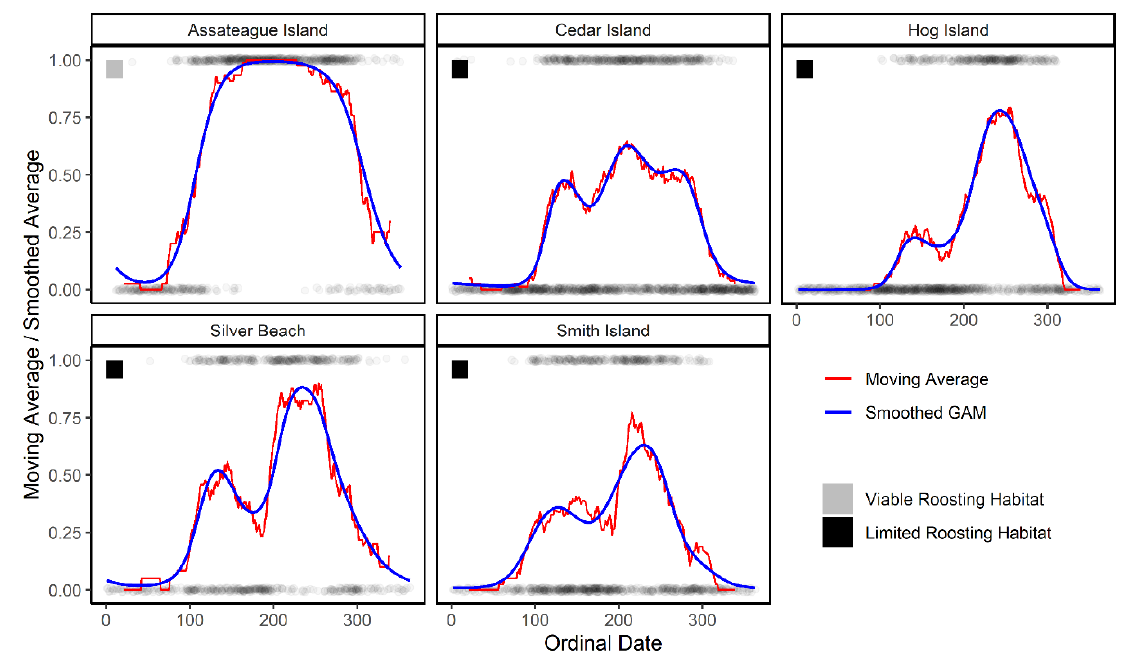
Figure 4. Raw occurrence data (black points: occurrence, non-occurrence (1, 0)) from acoustic detectors deployed on the Eastern Shore of Virginia, USA, 2012–2019. Data is grouped by site for all years of data collection stacked on a 1–366 ordinal date calendar. The raw data is shown as semi-transparent to visualize the occurrence density across years. Additionally overlaid are the results from the exploratory data analysis (EDA): the general relationship of tree bat nightly occurrence vs. ordinal date is represented by a 20-day two-sided moving average proportion of nightly occurrence (red line) and smoothed average using a generalized additive model (GAM) spline (blue line). Each site is labeled as containing viable day-roosting habitat (grey square) or limited day-roosting habitat (black square). Table 2. The 90%, 95%, and 99% quantiles representing the proportion of nights with tree bat occurrence under certain conditions of wind speed, temperature, and/ or date ranges using acoustic data collected on the Eastern Shore of Virginia, USA,